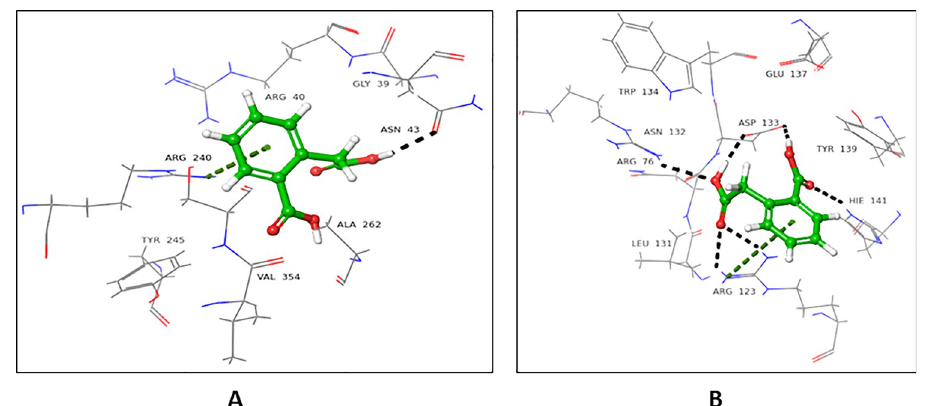
Fig 10. Interactions of compound 26 with the (A) donor and (B) acceptor domain FUT2. 3D Ligand interactions diagram; green dashed lines indicate π -cation bond, while black dashed lines represent hydrogen.